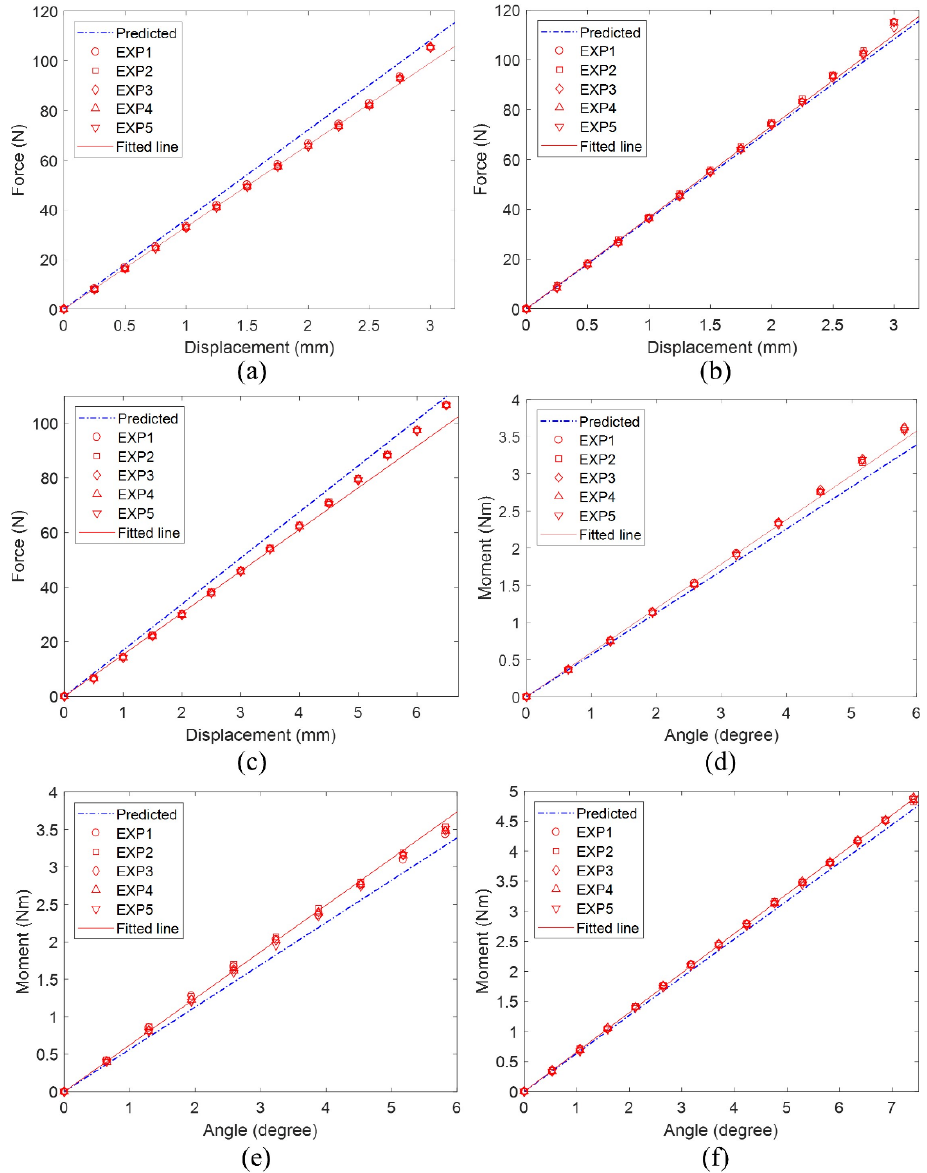
Figure 8. Experimental results of the 3D-printed CPM: ( a – c ) translational compliance along the X, Y, and Z axes, respectively; ( d – f ) rotational compliance about the X, Y, and Z axes, respectively.